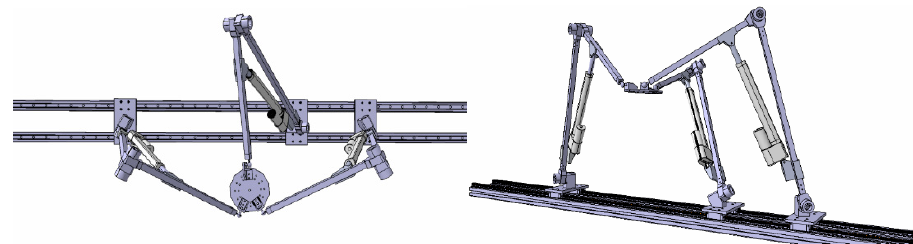
Figure 2. Views of the CAD model of the 6DOF PKM